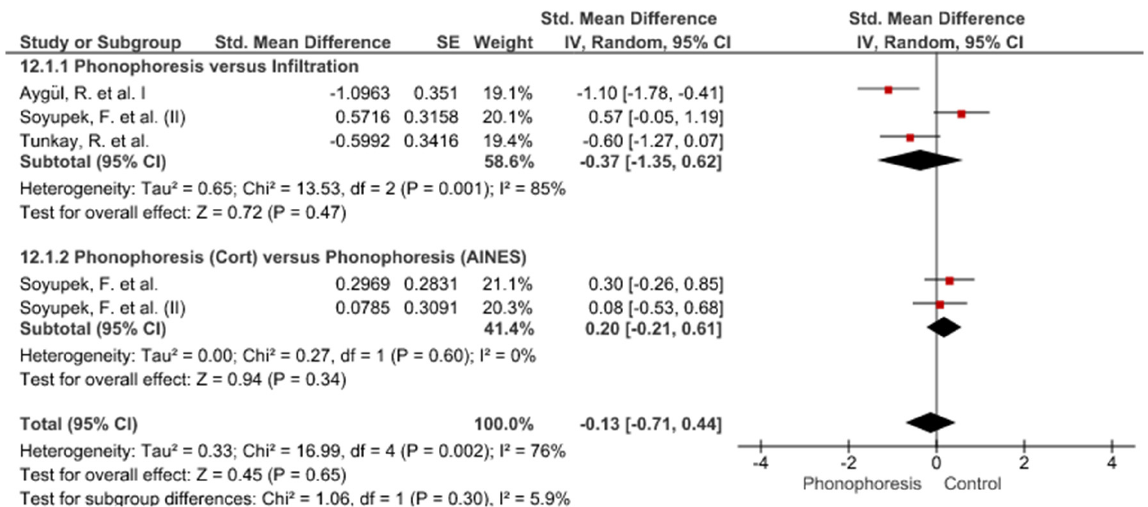
Figure 10. Phonophoresis for CNVM.